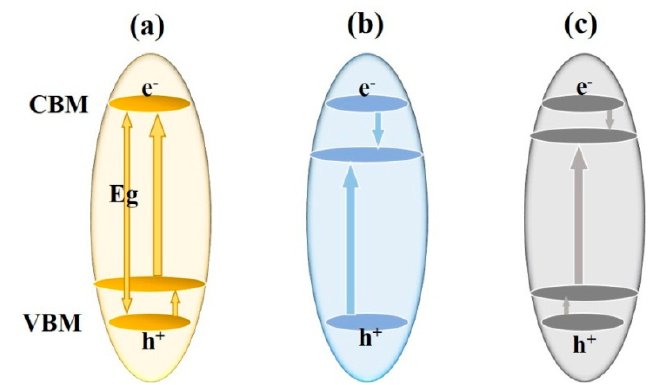
Figure 3. Three schemes of the band gap modifications of TiO 2 match the solar spectrum: ( a ) a higher shift in valence band maximum (VBM); ( b ) a lower shift in conduction band minimum (CBM); and ( c ) continuous modification of both VBM and CBM.